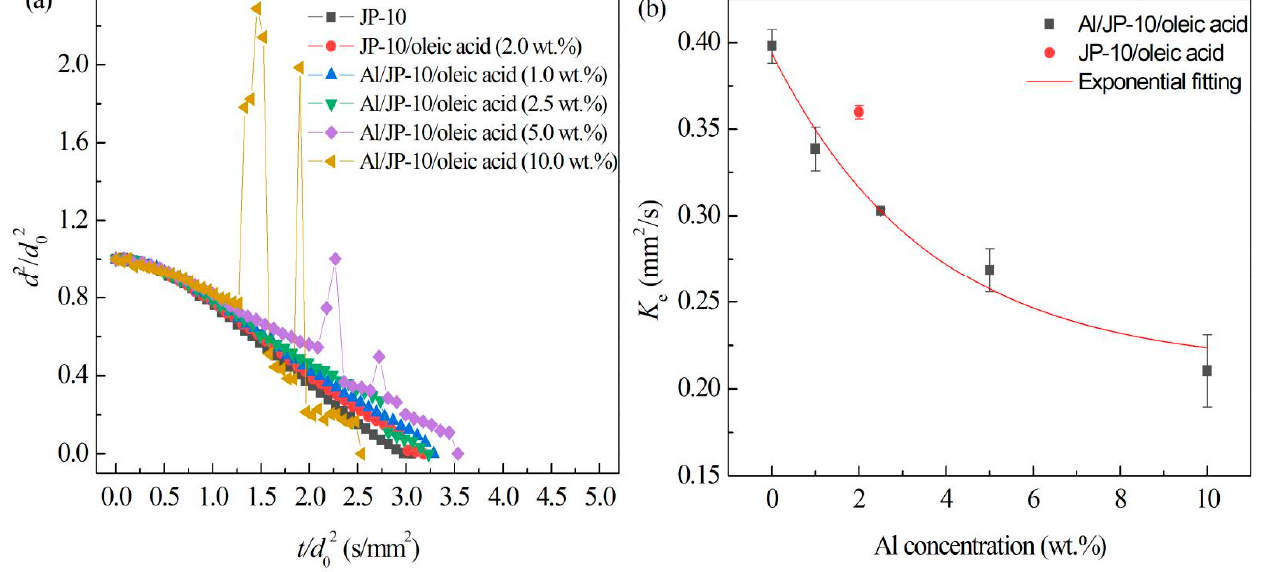
Figure 10. Evaporation of Al/JP-10/oleic acid nanofluid fuels at different Al concentrations. ( a ) Var- iation of droplet diameter with the evaporation time, ( b ) evaporation rates at different Al concen- trations.